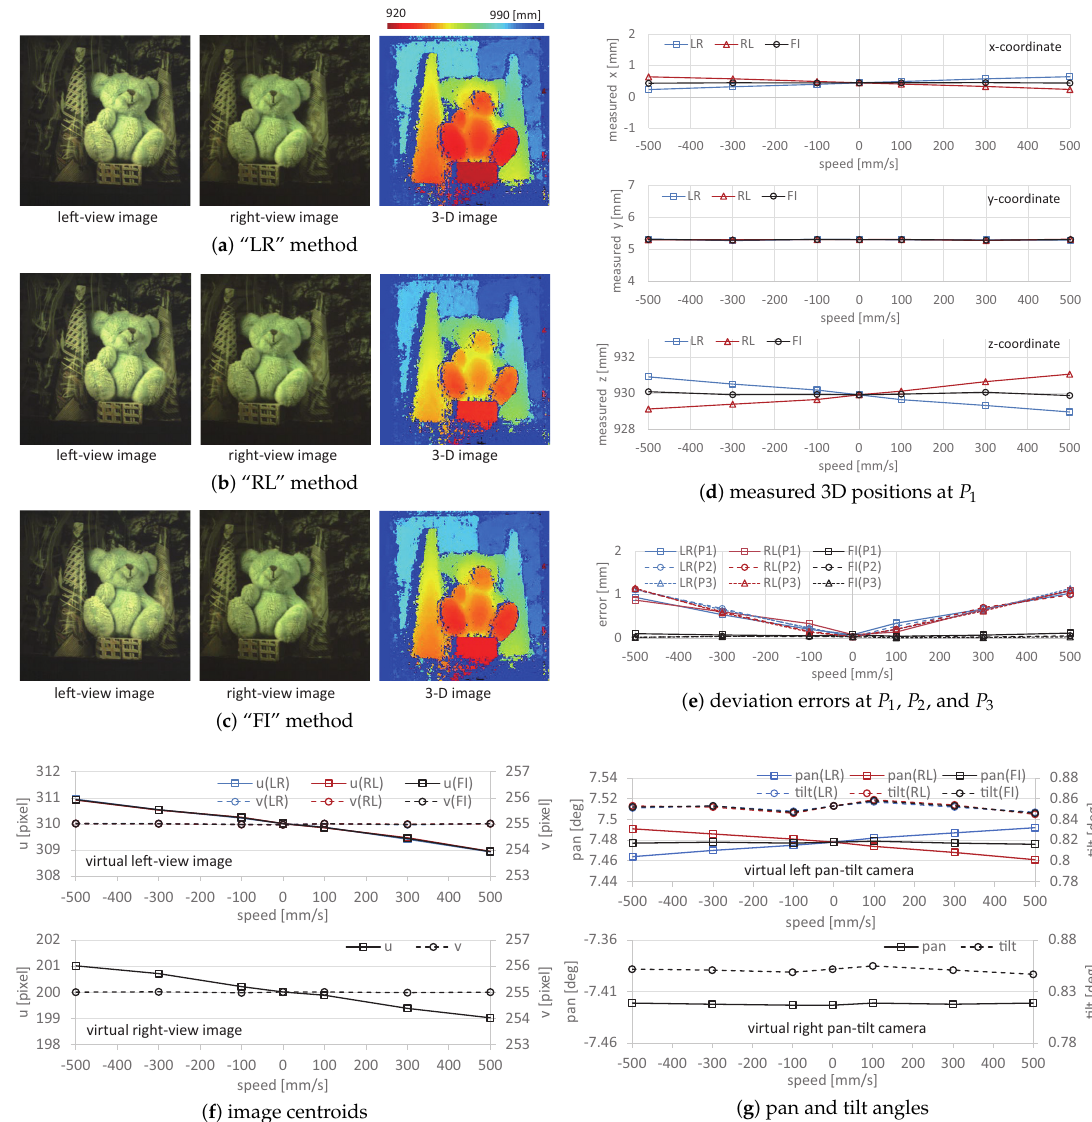
Figure 15. Left- and right-view images, measured 3D images and positions, deviation errors, image centroids, and pan and tilt angles of virtual left and right pan-tilt cameras when moving at 500 mm/s in the z -direction: ( a ) “LR” method; ( b ) “RL” method; ( c ) “FI” method; ( d ) measured 3D positions at P 1 ; ( e ) deviation errors at P 1 , P 2 , and P 3 ; ( f ) image centroids; ( g ) pan and tilt